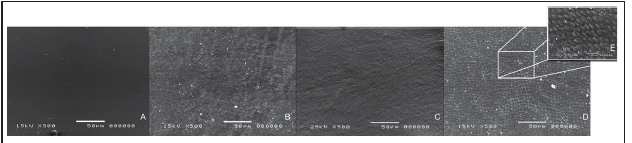
Fig. 2 – Representative SEM micrographs of bovine enamel at baseline (A) and after immersion in 0.6% citric acid (positive control) for 5 min (B), 15 min (C) and 30 min (D). Note extensive eroded areas at higher magnification (x2000) (E).